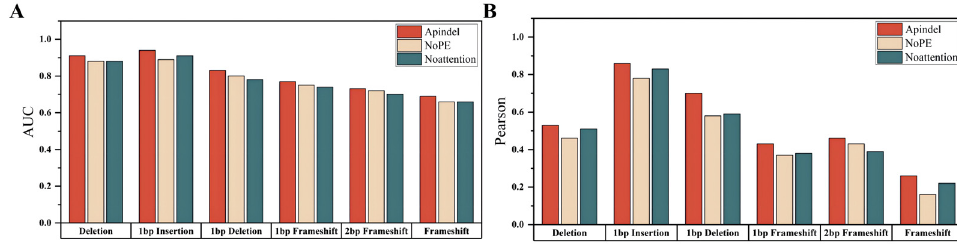
Figure 3. Performance evaluation of pre-selected models on the FORECasT dataset. ( A , B ) Apindel performed well under both evaluation metrics combined. The horizontal coordinates were the pre- selected models and the prediction tasks, and the vertical coordinates were the results under AUC and Pearson, respectively.